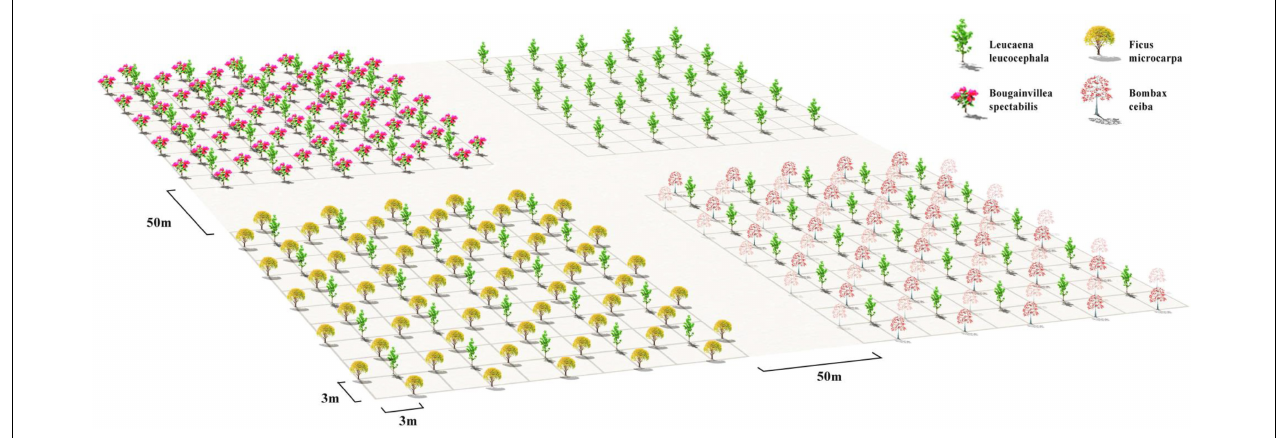
FIGURE 4 | The design of L. leucocephala monocultures (MLL), mixed plantation of B. spectabilis and L. leucocephala, mixed plantation of B. ceiba and L. leucocephala, and mixed plantation of F. microcarpa and L. leucocephala. MLL is made of 25 monocultured seedlings of L. leucocephala at 3 m spacing. BS vs. LL1 is mixing 100 B. spectabilis seedings with 25 L. leucocephala seedlings at 3 × 3 m spacing, with 4 B. spectabilis seedings surrounding one L. leucocephala seedling. Mixed plantation of B. ceiba and L. leucocephala, and mixed plantation of F. microcarpa and L. leucocephala uses the same mixing design as mixed plantation of B. spectabilis and L. leucocephala .